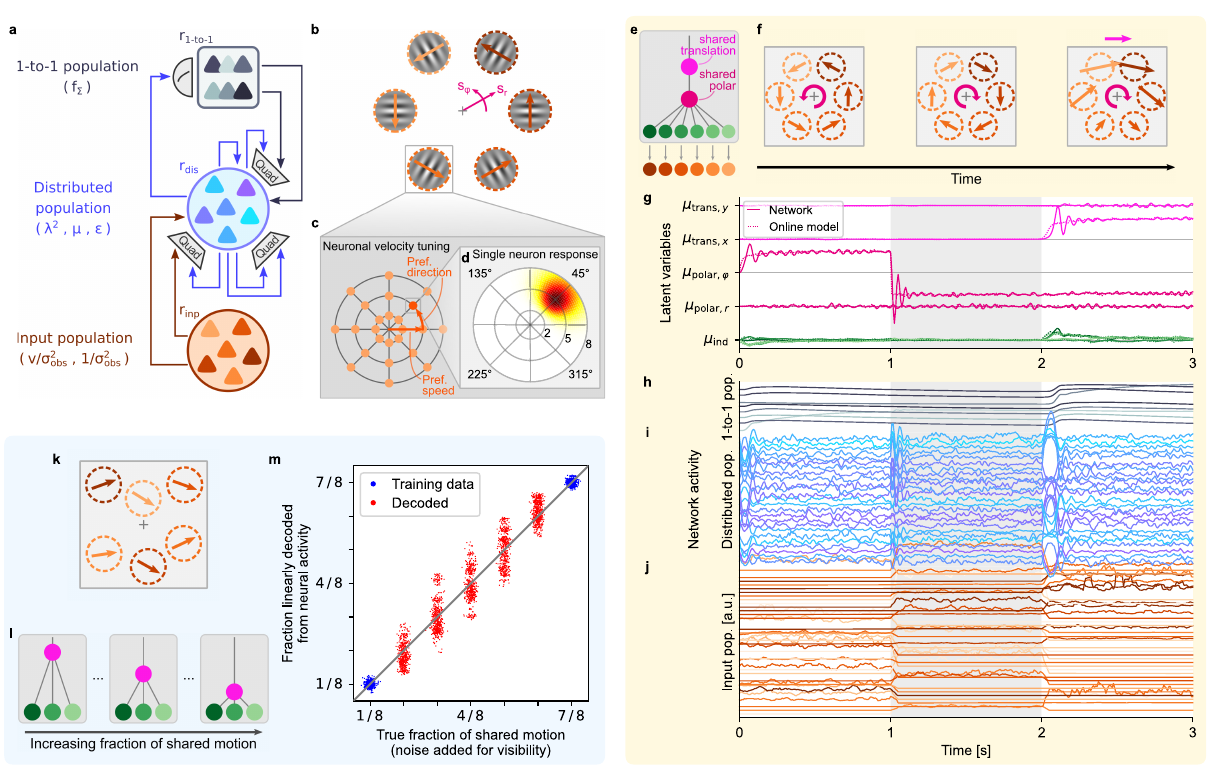
Fig. 7 | Hierarchical inference can be performed by a biologically realistic network model. a Network model implementing the online hierarchical inference model. Linear and quadratic interactions are indicated by direct arrows and Quad boxes, respectively. In parentheses, the variables represented by each population. b Rotational stimulus in a location-indexed experiment. Besides translational (Cartesian) motion, the model also supports rotational, s φ , and radial motion, s r . c TuningcentersinamodelofareaMT.Alocalpopulationofneurons,whichshare the spatial receptive fi eld highlighted in panel b , cover all directions and speeds with their velocity tuning centers. d Response function for the neuron highlighted in panel c . The neuron responds strongly to local velocities into the upper-right directionwithaspeedof ~5°/sec.Max.rate=29.5spikes/s. e Motionstructureused for the network simulation in panels f – j , including simultaneous translational, rotational and radial motion sources. f Illustration of the stimulus. After 1 s of counter-clockwise rotation around the fi xation cross, the rotation switches to clockwise. At t =2s, rightward translation is superimposed on the rotation. g Motion sources inferredbythenetwork(solidlines: distributedpopulationread- out;dottedlines:solutionbytheonlinemodelgivenbyEqs.(1) – (3)).Shownis μ t for